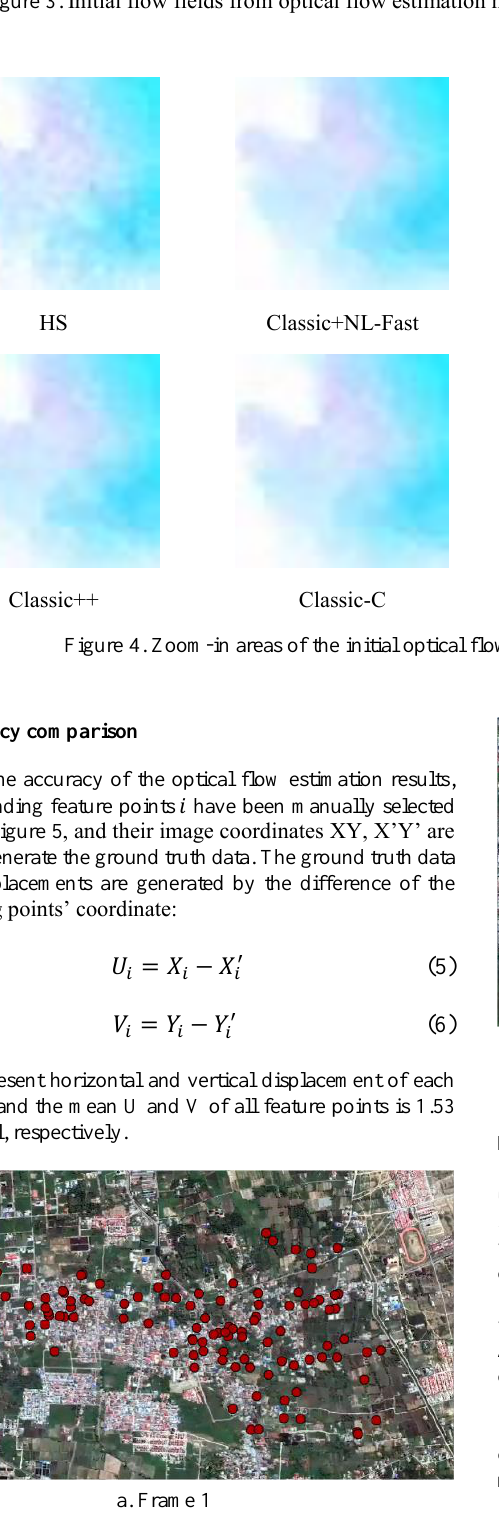
Figure 3. Initial flow fields from optical flow estimation methods on images from Digital Globe’s WorldView